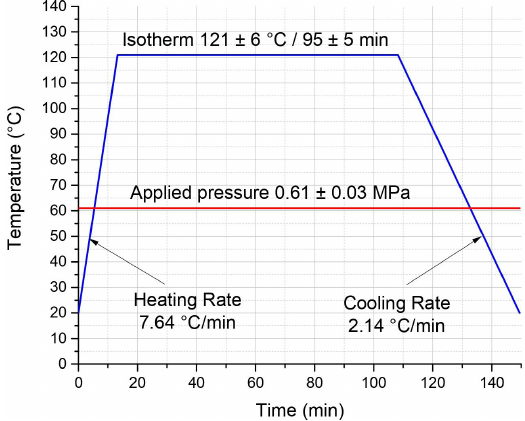
Figure 3. Curing cycle of epoxy resin